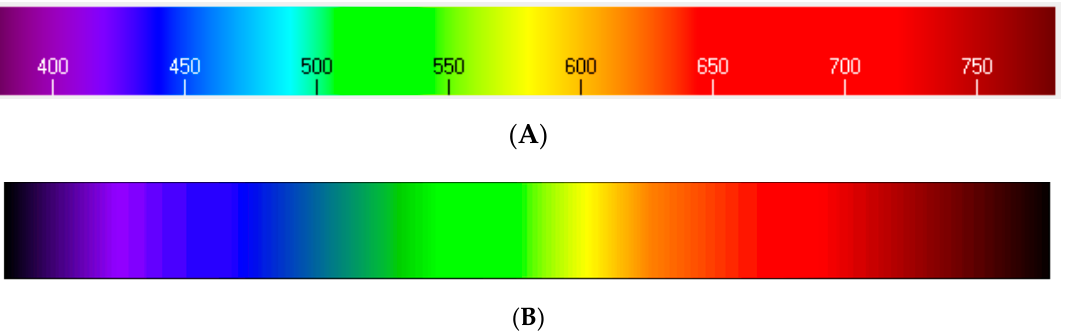
Figure 13. ( A ) Comparative visible spectrum based on RGB equivalence equations- λ . ( B ) Real visible spectrum.